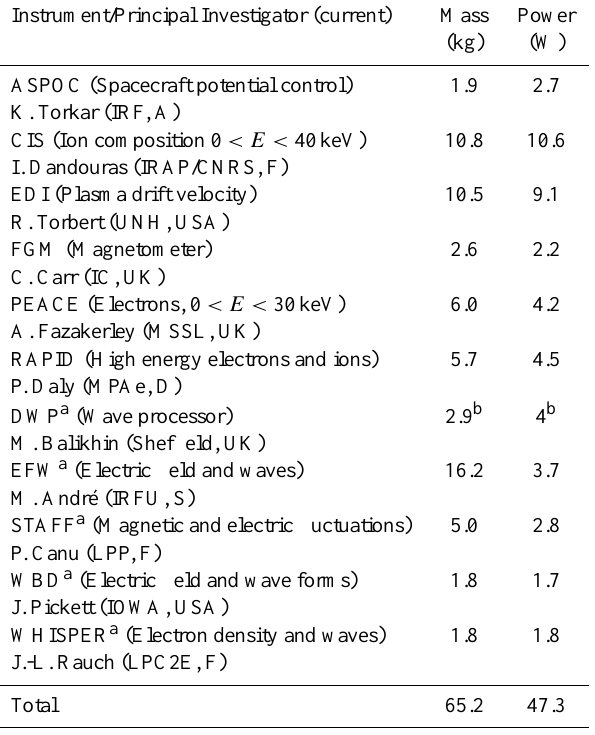
Table 3. The 11 instruments on each of the four Cluster